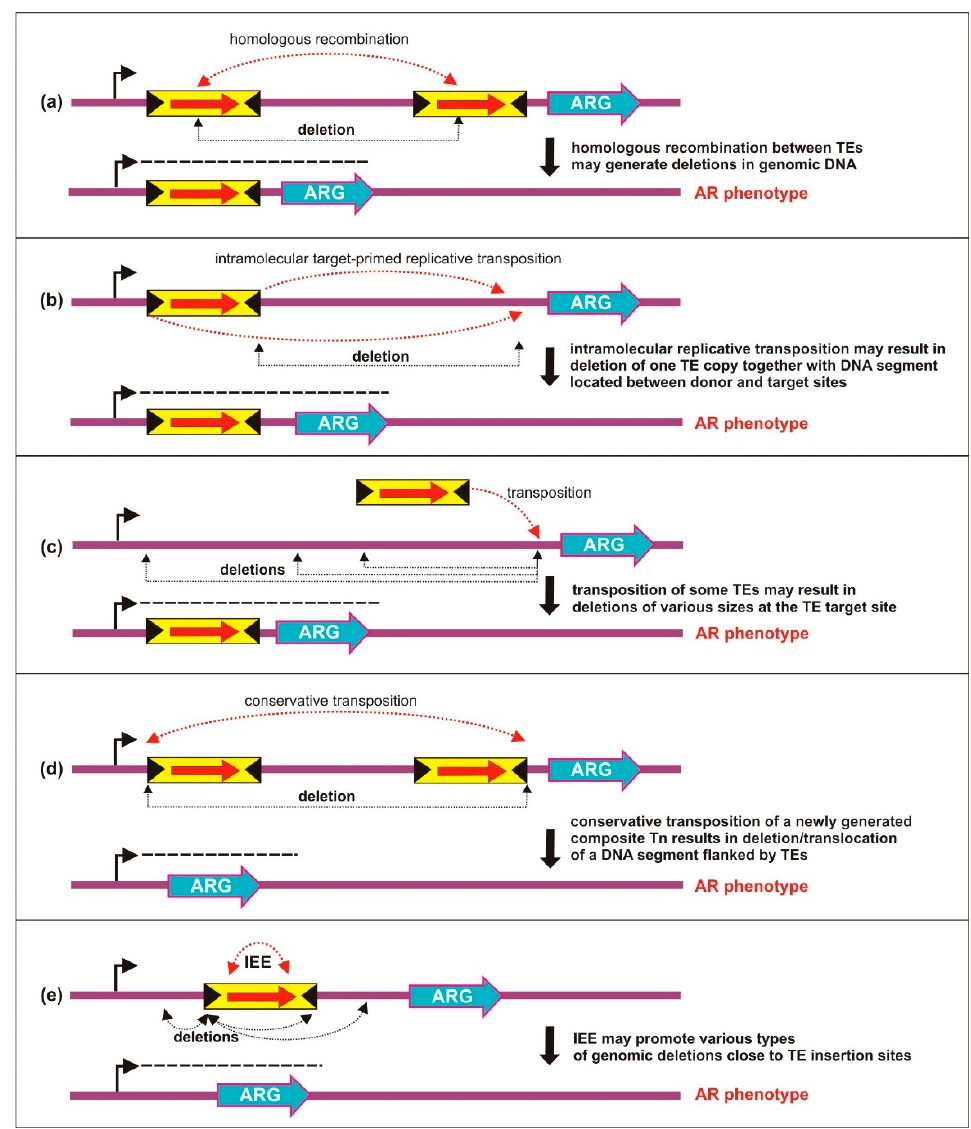
Figure 3. TE-induced deletions leading to activation or modulation of expression of AR genes from distantly located promoters. Deletions generated by ( a ) homologous recombination; ( b ) intramolecular replicative transposition; ( c ) transposition of IS 21 -family members; ( d ) conservative transposition; ( e ) IS excision enhancer protein. ARG—antibiotic resistance gene; IEE—IS excision enhancer protein. Symbols are identical to those in Figure 2. See text for details.